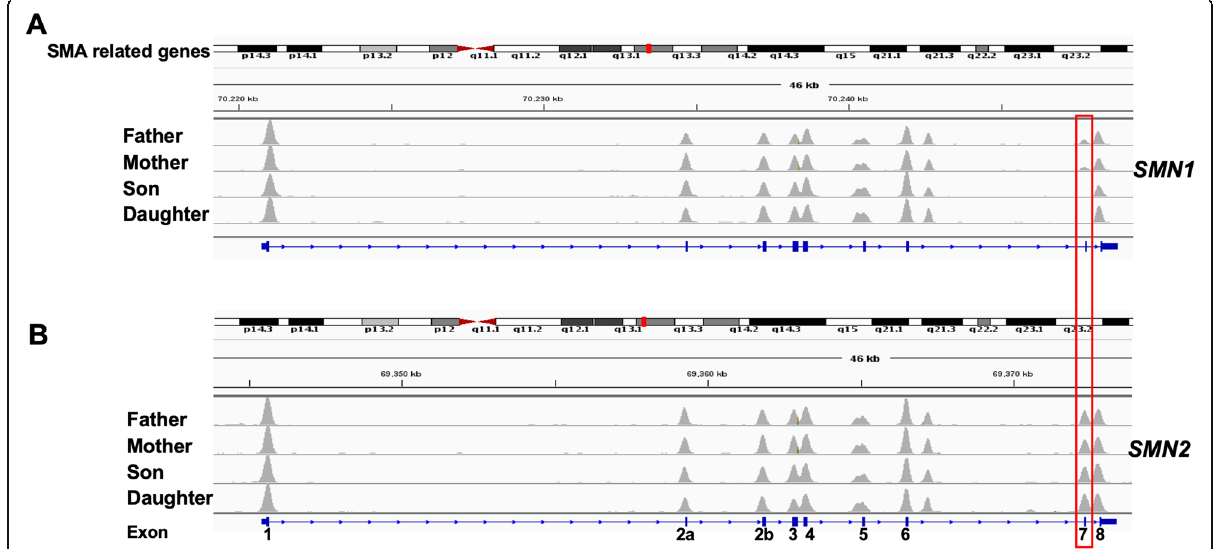
Fig. 1 Reads coverages in SMN exon regions. The four family members were sequenced by WES and the reads were aligned to the exon regions of SMN1 ( a ) and SMN2 ( b ). The grey peaks indicate the richness of the reads that mapped to the corresponding exon region in each sample. The red box indicates the alignment coverages of exon 7 of SMN1 and SMN2 in each sample